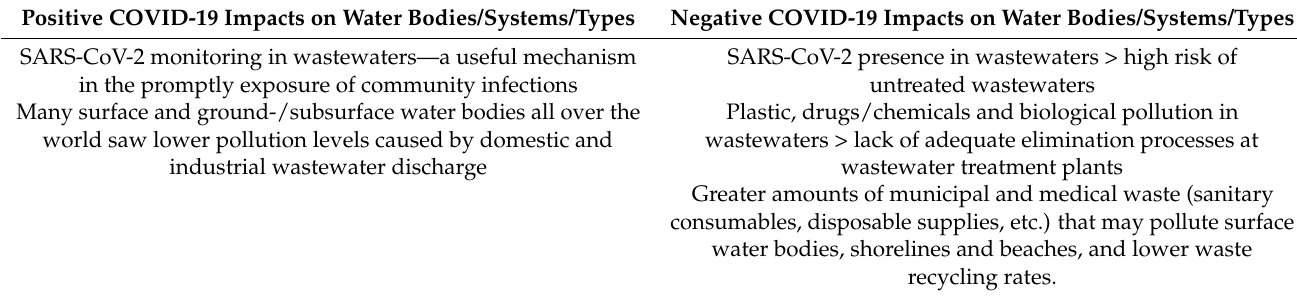
Table 2. Positive and negative COVID-19 impacts on water